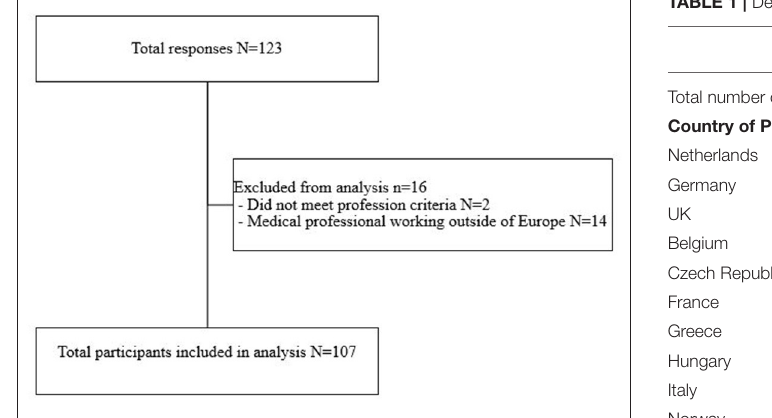
FIGURE 1 | Inclusion of